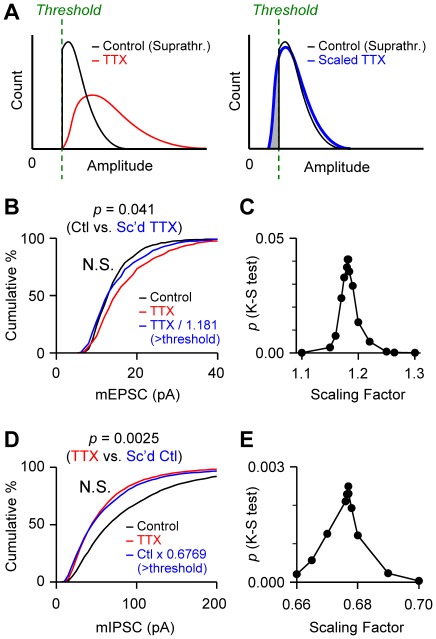
A new method of testing for the occurrence of multiplicative scaling.
A. Schematic diagrams of distributions of mEPSC amplitudes illustrate the new method of estimating a true multiplicative scaling factor. Only suprathreshold data (Suprathr.) are shown in the left graph. Multiplicative down-scaling of TTX data (from red curve to blue one) results in a small portion of data (gray) falling below the detection threshold. Because the data in the gray area are invisible in experimental recording, they are discarded for comparison with the control data. The degree of overlap is measured between the control (black curve) and the scaled TTX data (blue curve) excluding the gray area. B. Cumulative histograms of experimental data shown in Fig. 1A. To derive the distribution of scaled TTX data (blue), the TTX-treated mEPSCs were divided by 1.181, which yielded the maximum overlap between control and scaled TTX data excluding subthreshold values. The threshold is defined as the smallest detectable amplitude of control mEPSCs. A K-S test showed no significant difference between control and scaled TTX groups (p>10−4), suggesting the occurrence of multiplicative scaling. C. With other scaling factors, the degrees of overlap between control and scaled TTX data excluding subthreshold values were also examined. The degree of overlap of the histograms was quantified by confidence level (p value) of K-S test. The largest p (0.041) was obtained when mEPSC amplitudes of the TTX group were divided by 1.181. D. A test for multiplicative scaling was performed with mIPSCs in a similar manner to that in A–C. Because the mean amplitude of control mIPSCs was larger than that of TTX-treated ones, control mIPSC amplitudes were scaled down by multiplying by 0.6769. A K-S test between scaled control and TTX data (p>10−4) revealed multiplicative scaling. E. The degrees of overlap between scaled control and TTX data excluding subthreshold values were assessed with various scaling factors. The largest p (0.0025) was obtained with a scaling factor of 0.6769.